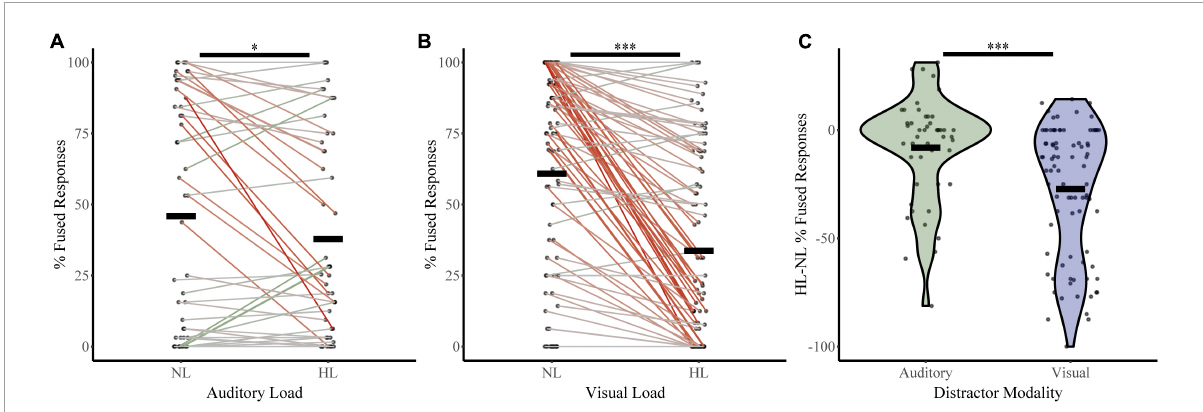
FIGURE3 McGurk fused reports for no load (NL) and high load (HL) bocks. The percent of fused reports (“da” or “tha”) during NL and HL blocks are shown for each participant for the auditory distractor (A) and visual distractor (B) tasks. Horizontal black bars indicate group averages. Colored lines connect individual percent fused reports across each block with a green line indicating an increase in fused reports from NL to HL and a red line indicating a decrease. The difference in percent fused reports across load for rapid serial visual presentation (RSVP) and rapid serial auditory presentation (RSAP) tasks is shown in panel (C) . ∗∗∗ Indicates p < 0.001 and ∗ indicates p < 0.05.